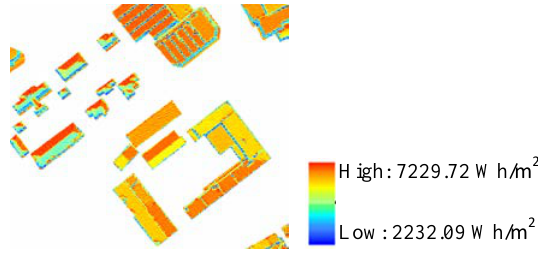
Figure 6. Mean annual global solar